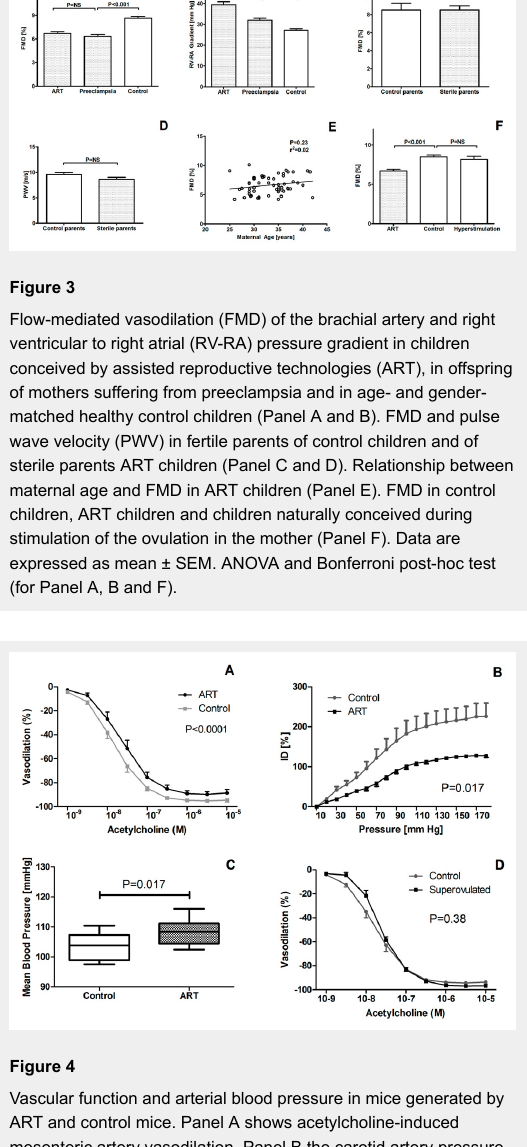
Vascular function and arterial blood pressure in mice generated by ART and control mice. Panel A shows acetylcholine-induced mesenteric artery vasodilation, Panel B the carotid artery pressure- diameter relationship, a proxy of vascular stiffness, Panel C shows mean arterial blood pressure obtained by telemetry. Panel D shows acetylcholine-induced mesenteric artery vasodilation in mice conceived during stimulation of the ovulation in the mother and control